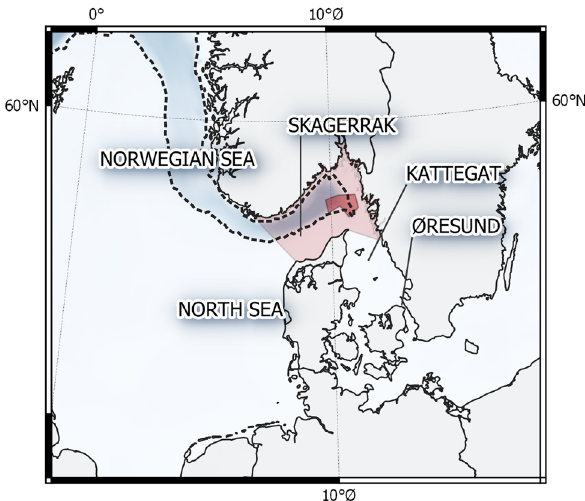
Figure 1. Map showing the seas around the Nordic countries. Dark red area shows catch and tagging area, larger light red areas denotes ICES Area 3a. The Norwegian Trench is the darker blue band following the Norwegian coastline. Map created with QGIS 3.14 (https:// www. qgis.